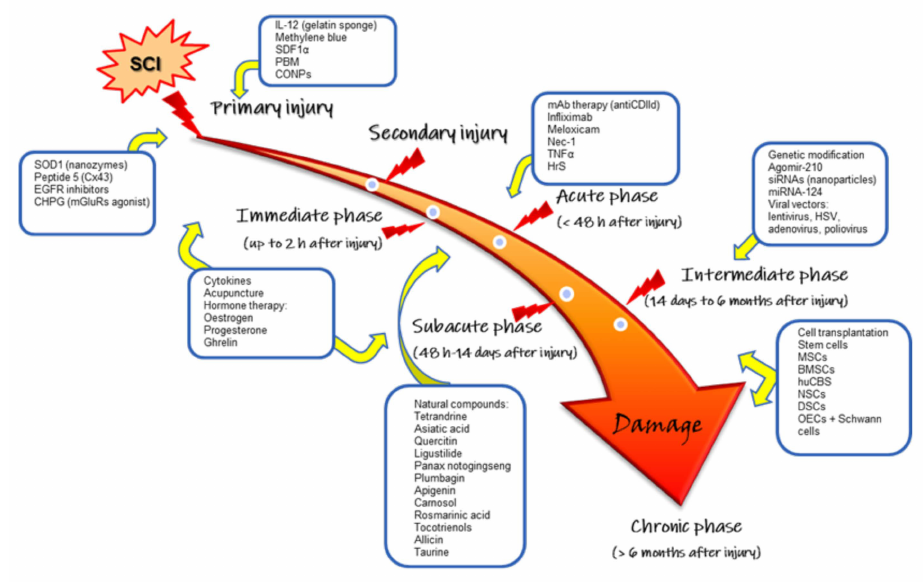
Figure 3. Different potential treatments were tested in animal models according to the stage or phase of spinal cord injury (SCI). After instantaneous damage (primary injury), secondary injury